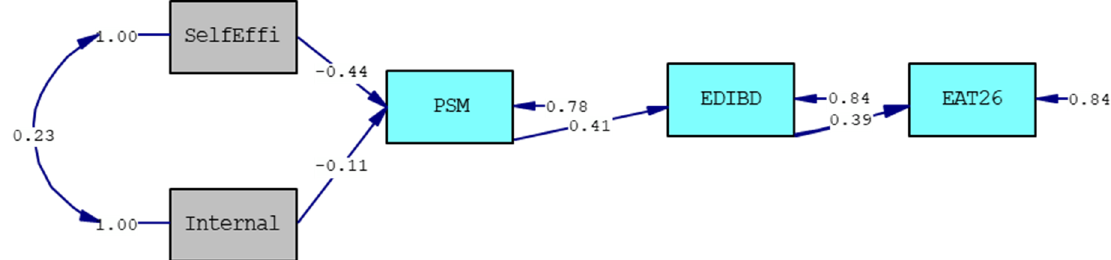
Figure 2. The Final Model (Model 1). Note. Selfeffi = self-efficacy; Internal = internal locus of control; PSM = perceived stress; EDIBD = body dissatisfaction; EAT26 = eating attitude disorder; chi-square = 9.05, df = 5, p -value = 0.10700, RMSEA = 0.052.